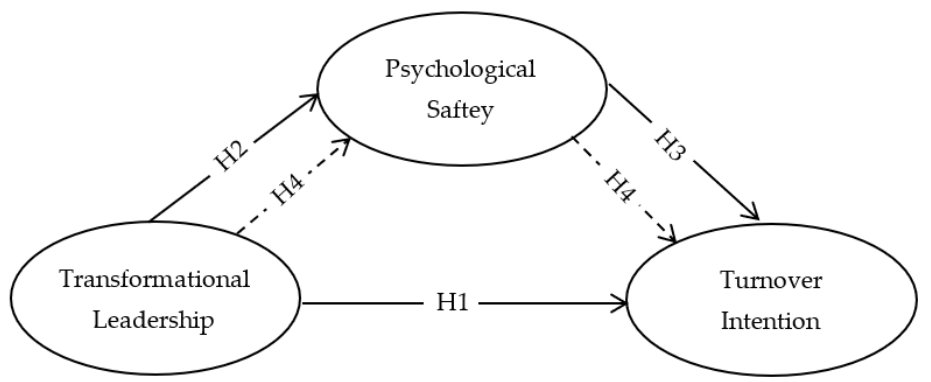
Figure 1. The theoretical model (developed based on the literature review; dotted lines reflect indirect effect).